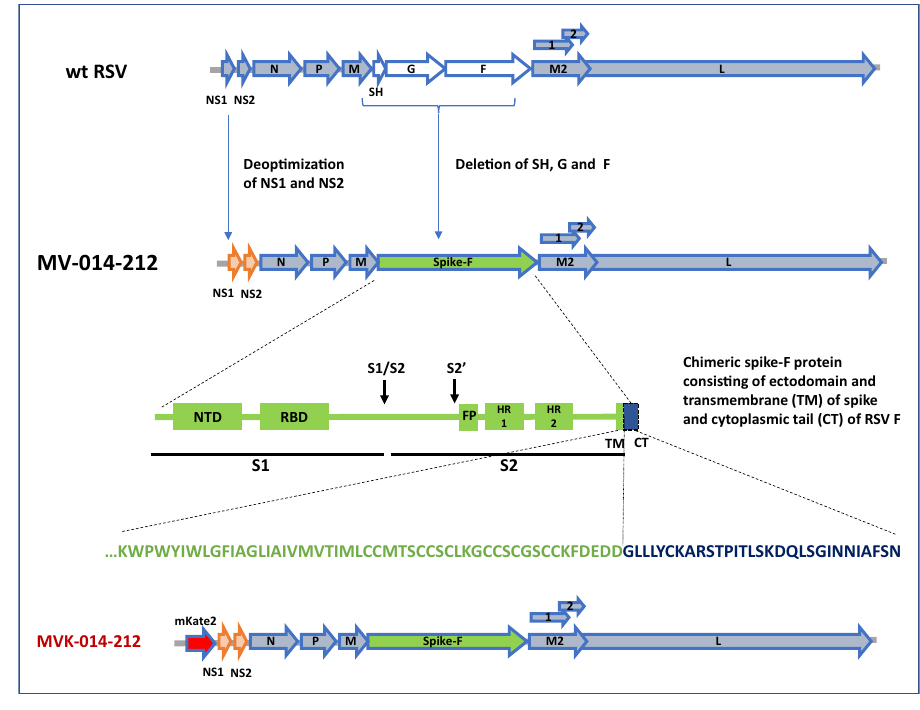
Fig. 1 Design of MV-014-212. In MV-014-212, the NS1 and NS2 genes are codon deoptimized and the respiratory syncytial virus (RSV) SH , G , and F genes are deleted and replaced by a gene encoding a chimeric Spike protein. The amino acid sequence at the junction is shown. The transmembrane domain of spike is represented in green, and the cytoplasmic tail of F is depicted in blue. The reporter virus MVK-014-212, encoding the fl uorescent protein mKate2 in the fi rst gene position, is schematically shown at the bottom of the panel. FP, fusion peptide; HR1 and 2, heptad repeats 1 and 2; NTD, N-terminal domain; RBD, receptor binding domain; S1, subunit S1; S2, subunit S2; S1/S2 and S2 ’ , protease cleavage sites; wt, wild